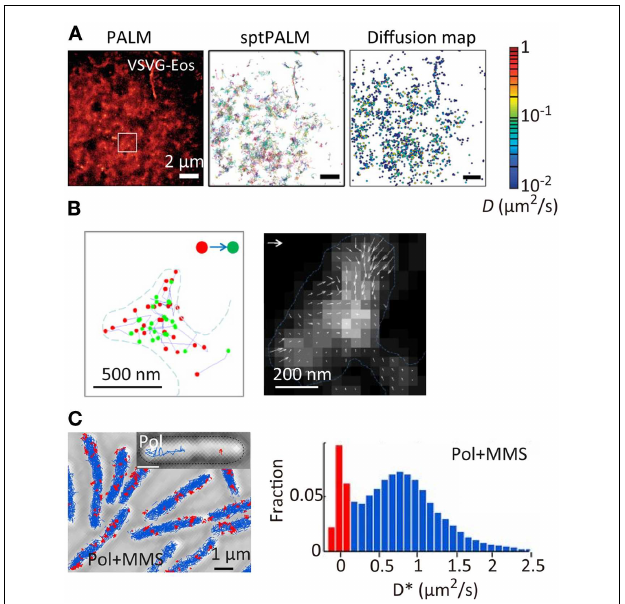
FIGURE 4 | Super-resolution fluorescence molecular imaging. (A) PALM image, sptPALM image, and diffusion map of a membrane protein,VSVG, in COS7 cells. A photoconvertable fluorescent protein tdEosFP is fused to VSVG.The PALM image was obtained by the temporal activation of tdEosFP–VSVG followed by the localization and reconstruction of the image. The sptPALM image was obtained by tracking the activated tdEosFP–VSVG molecules.The diffusion map was obtained by calculating the diffusion coefficient of individual tdEosFP–VSVG molecules using the diffusion trajectories (Manley et al., 2008). (B) (Left) the first (red) and last (green) localized positions of single actin molecules within dendritic